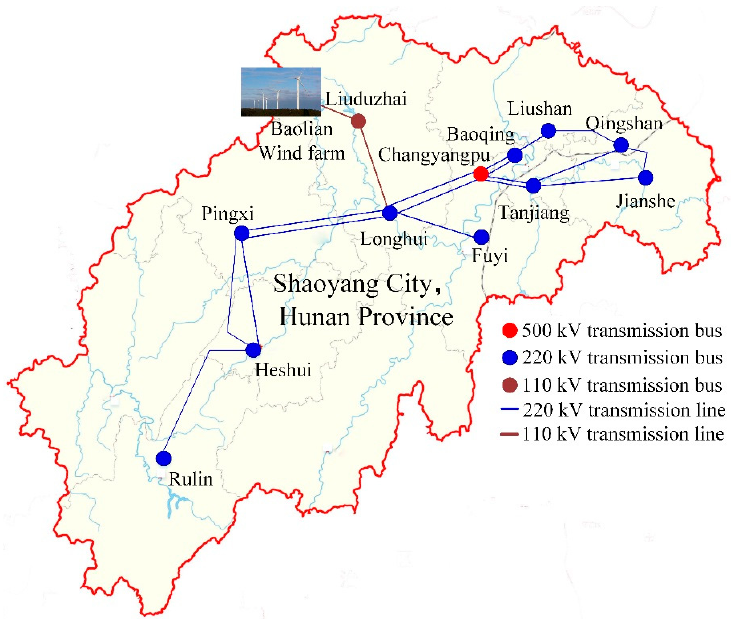
Figure 6. Geographical information of the Baolian wind farm.